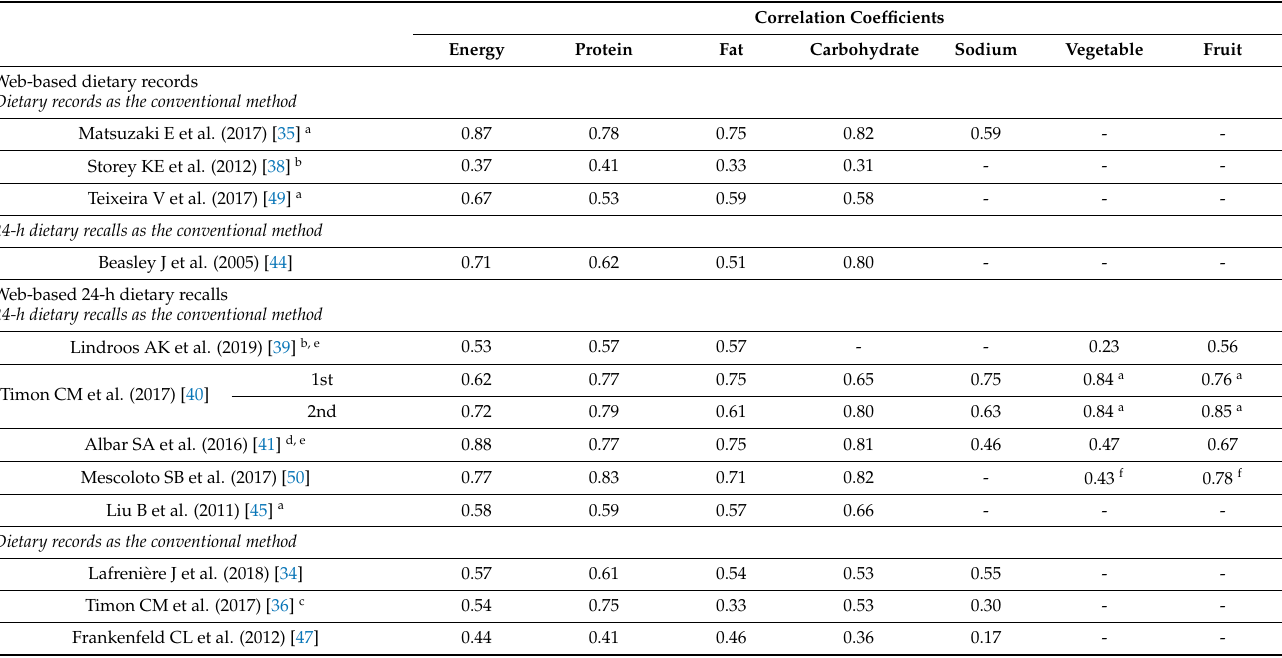
Table 3. Correlation coefficients for intakes of energy, macronutrient, vegetable, and fruit between web-based and conventional dietary assessment